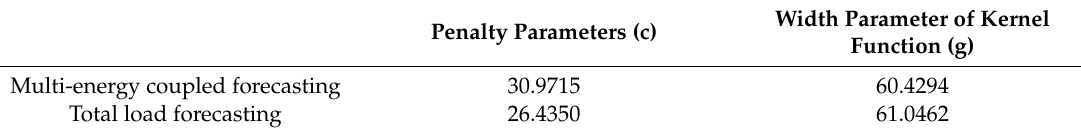
Table 7. LSSVM parameter settings after